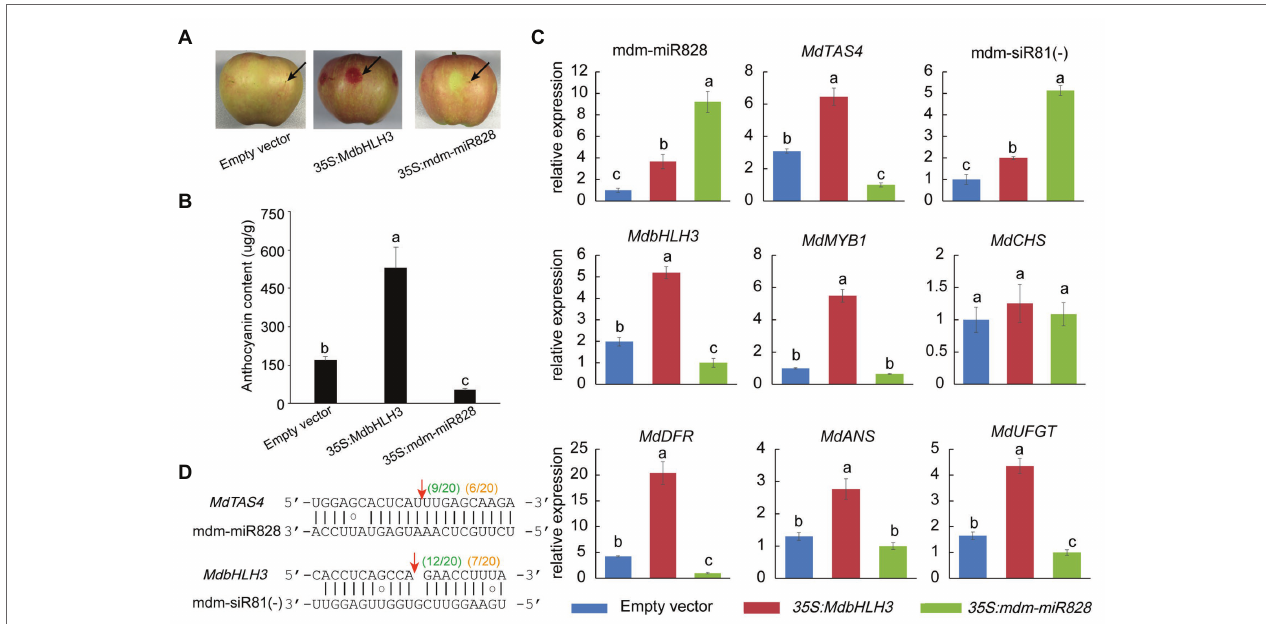
FIGURE 2 | Transient expression of mdm-miR828 in apple “Starkrimson Delicious” fruit. (A) Overexpression of mdm-miR828 inhibits anthocyanin accumulation in the peel. The black arrows represent the injection sites. (B) Anthocyanin content in the peel of fruit overexpressing mdm-miR828 or MdbHLH3 . (C) Overexpression of mdm-miR828 and MdbHLH3 affects the expression level of anthocyanin biosynthesis-related genes in the peel. (D) The binding positions of mdm-miR828 and mdm-siR81( − ) in the target genes MdTAS4 and MdbHLH3 . Green numbers and orange numbers in parentheses indicate the proportion of 5 ' -RACE clones at the sites where the target gene is cleaved by mdm-miR828 and mdm-siR81( − ) in mdm-miR828-overexpressing peel and mixed peels (harvested at 134, 140, and 146 days after blooming), respectively. Error bars represent the standard deviation of three biological replicates. Different letters above the bars indicate a significant difference ( p < 0.05, one-way ANOVA and LSD